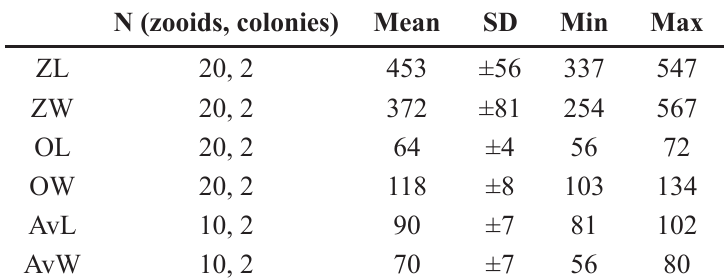
Table 4. Measurements in microns of Microporella rusti sp. nov., Nukumaruan, Pleistocene, Nukumaru